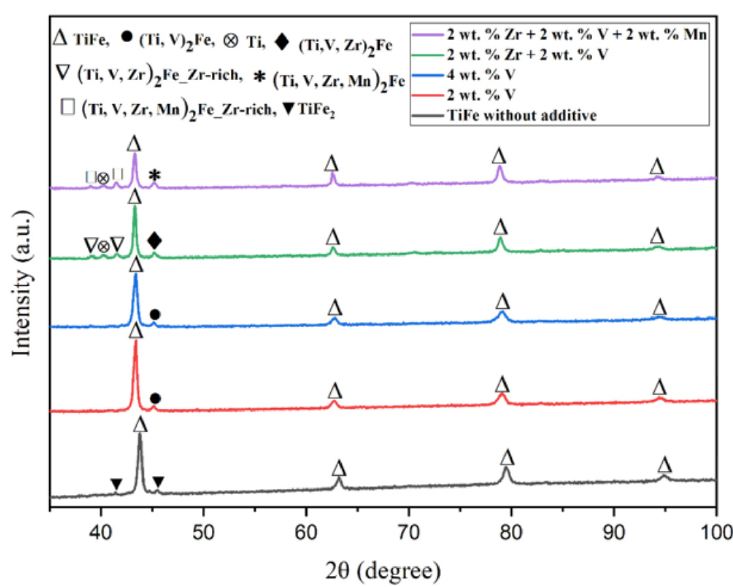
Figure 5. X-ray pattern of TiFe alloys with the addition of only V, Zr + V, and Zr + V + Mn. The without additive curve is reproduced with permission from Patel et al., Microstructure and first hydrogenation properties of TiFe alloy with Zr and Mn as additive; published by Elsevier, 2020. Table 5. Refined value of phase abundance, lattice parameters, crystallite size, cell volume and microstrains by Rietveld refinement of each alloy’s X-ray patterns. Error on the last significant digit is indicated in the